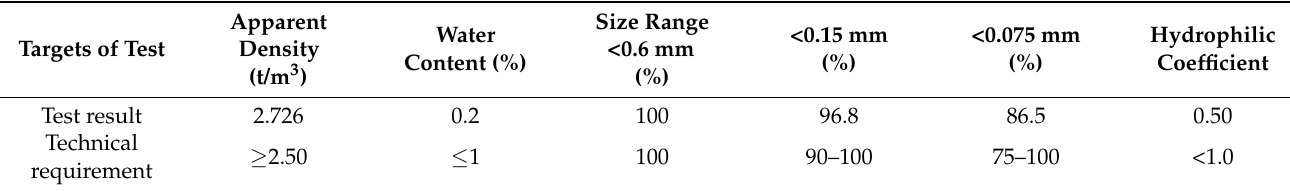
Table 6. Main technical indexes of mineral powder.